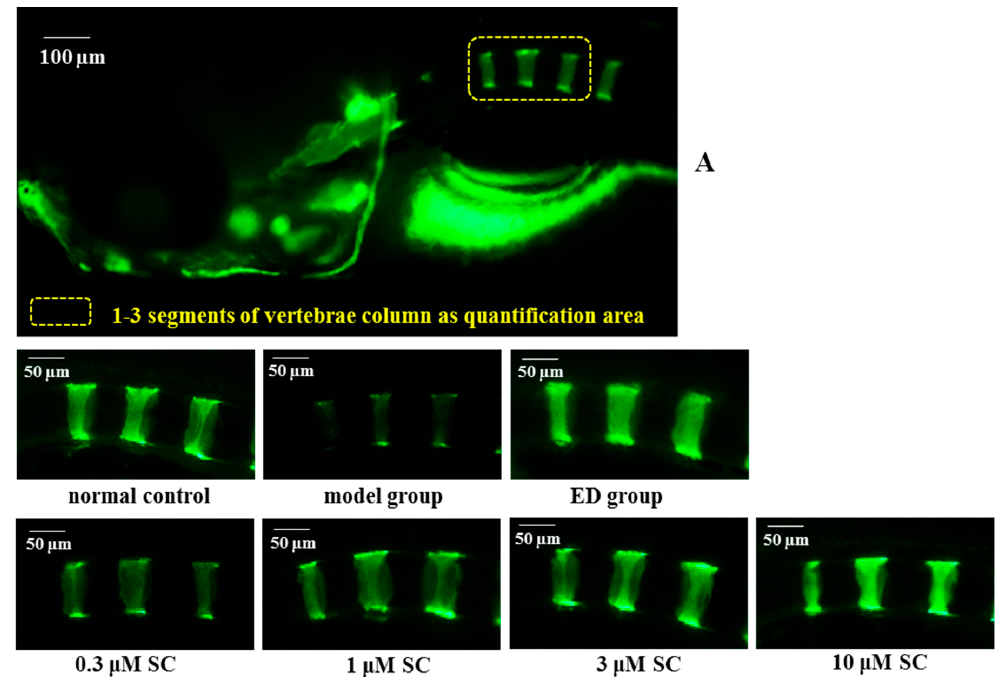
Figure 7. Evaluation of mineralization of the vertebrate column in SC-treated zebrafish. ( A ) The fluorescent images of the calcein-stained vertebrate column in the spinal region of zebrafish (the fluorescence intensity at the area of 1 to 3 segments of vertebrae was detected as quantification of mineralization degree). ( B ) Effect of SC on integrated optical density (IOD) of zebrafish larval (* p < 0.05, ** p < 0.01 vs prednisone-induced model group, n =